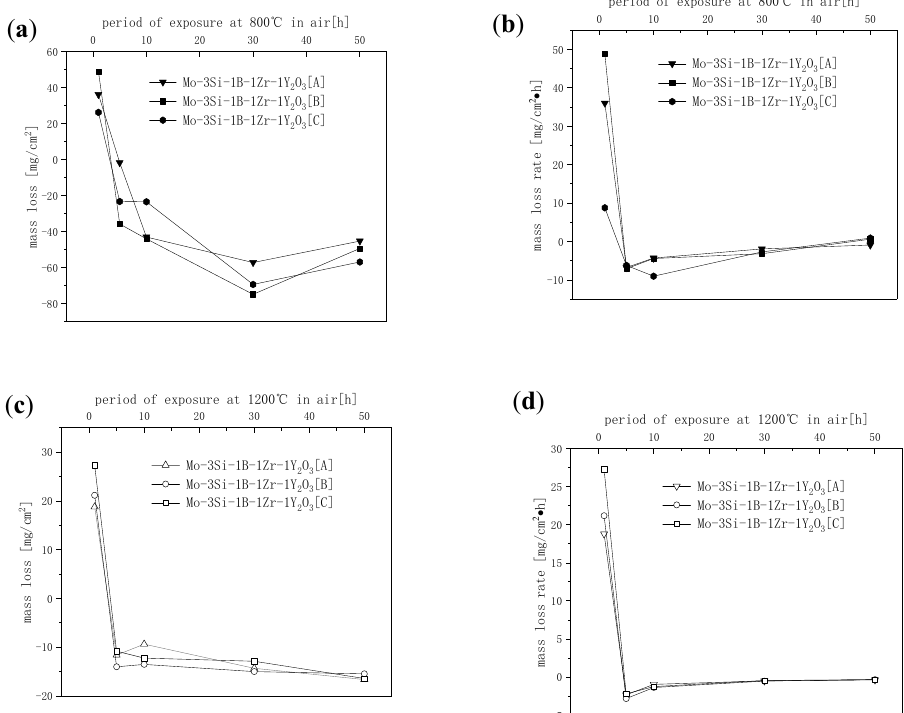
Figure 7. Change of Mo–3Si–1B–1Zr–1Y 2 O 3 alloy mass during 50 h time oxidation: ( a , b ) show mass loss of Mo–3Si–1B–1Zr–1Y 2 O 3 alloy at 800 ◦ C; ( c , d ) show mass loss of Mo–3Si–1B–1Zr–1Y 2 O 3 alloy at 1200 ◦ C